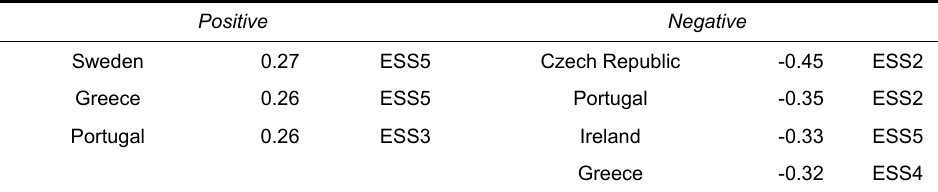
Table 2: Largest changes in net self-transcendence between consecutive ESS